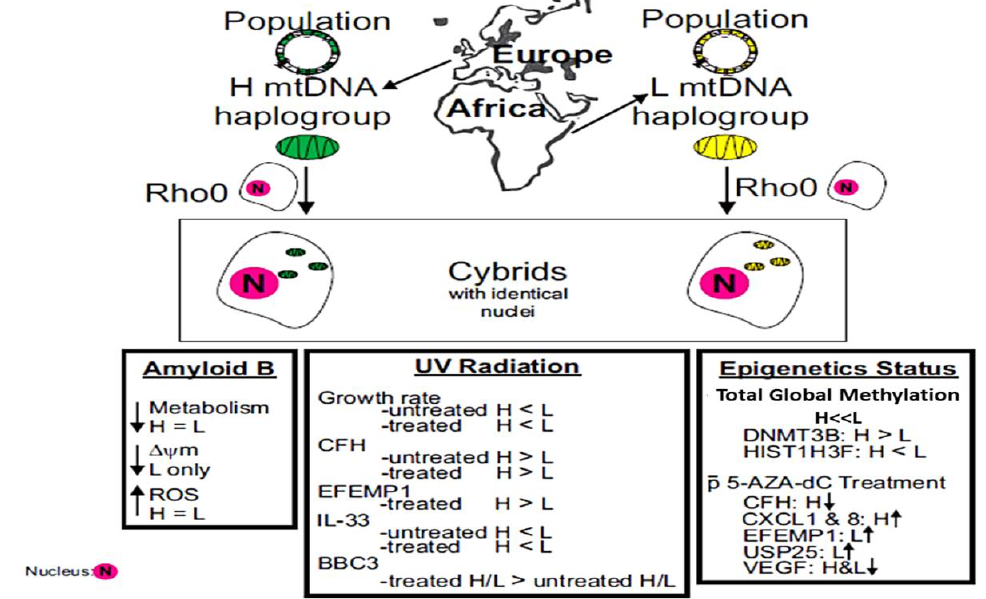
Figure 5. A schematic illustration of how the maternal mtDNA from African populations versus European populations can lead to various epigenetic profiles, which in turn may differentially regulate specific key pathways that are crucial for disease processes.